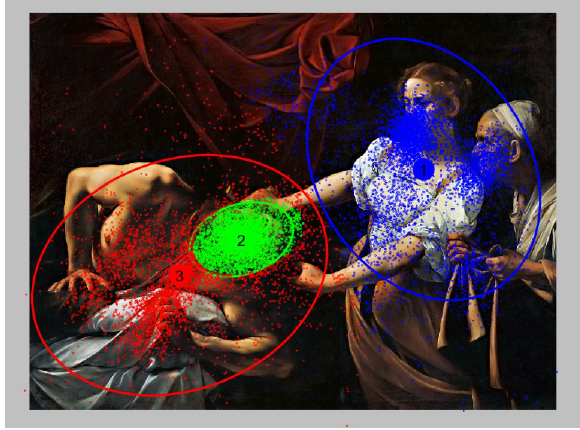
Figure 4. Fixation assignment to 3 clusters for the P2 image.